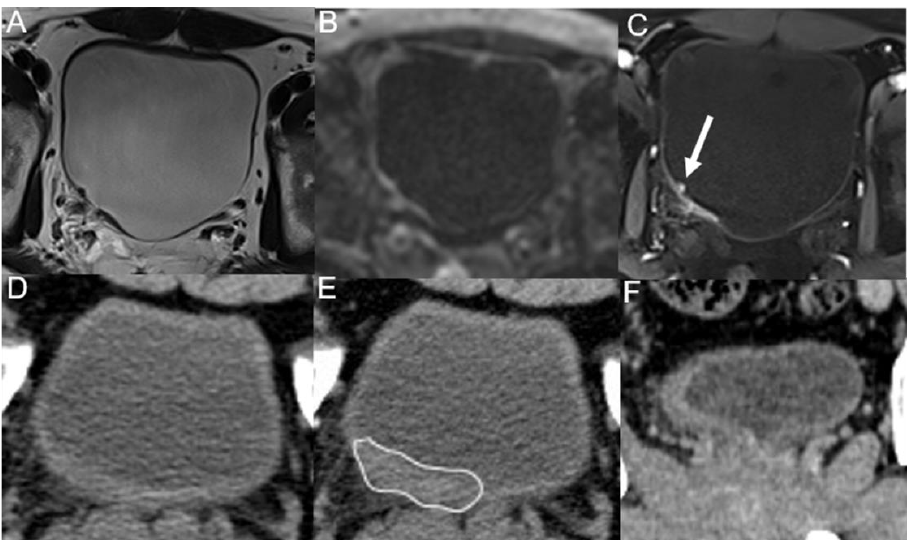
Figure 5. A 43-year-old man underwent trans-urethral resection of BC 5 months ago. T2WI ( A ),